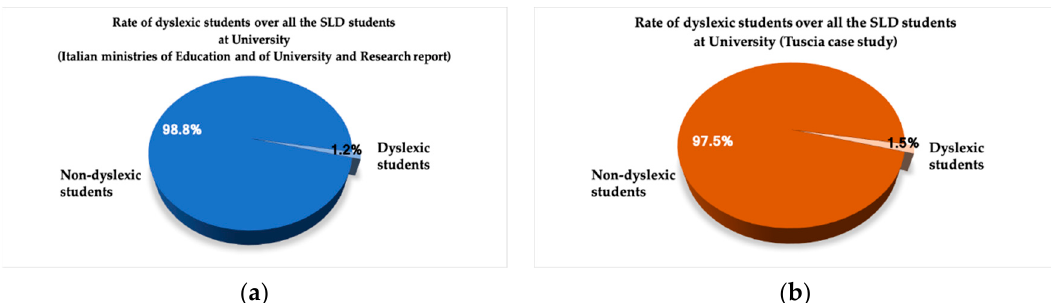
Figure 2. Rate of dyslexic students attending university according to the 2019 report of Ministry of Education and Ministry of University and Research [75] ( a ) and to Tuscia case study ( b ).